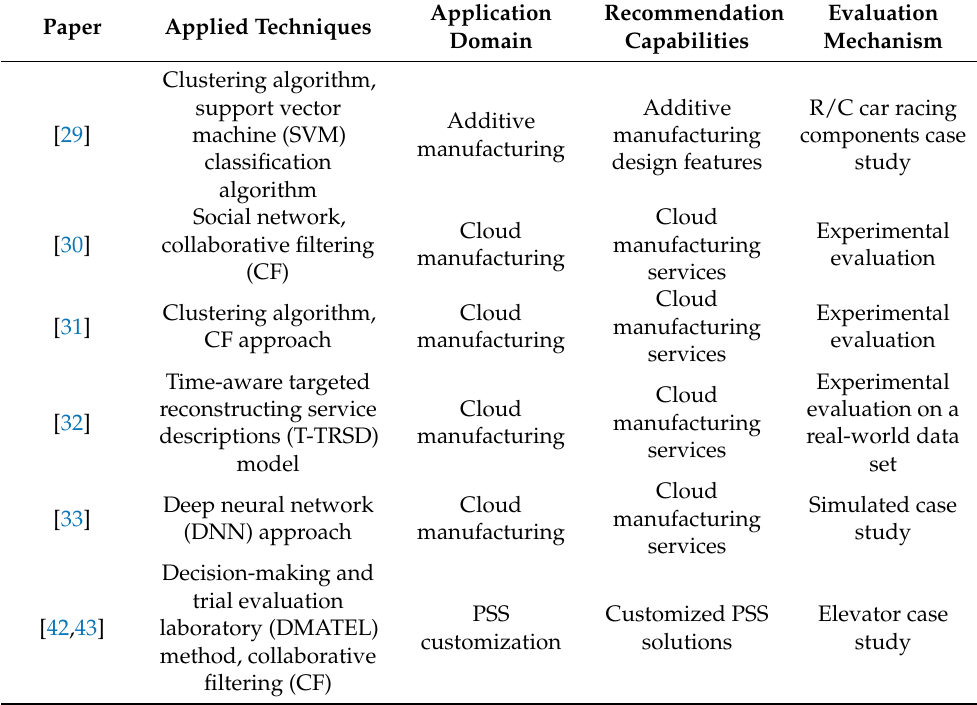
Table 2. Related work pertaining to recommendation approaches in